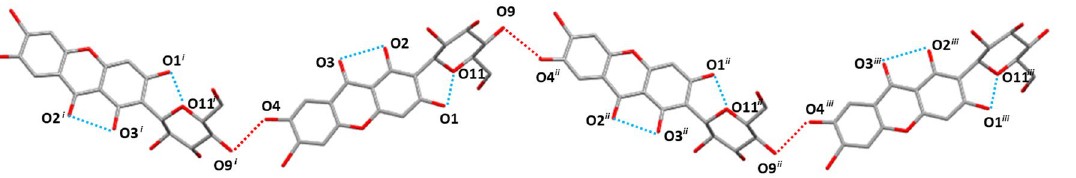
Fig. 3 Main hydrogen bonds of O–H ⋯ O along b-axis in form I (Tur- quoise dashed lines showed intramolecular actions of O 2 –H ⋯ O 3 and O 1 –H ⋯ O 11 , red dashed lines indicated O 9 –H ⋯ O 4 hydrogen